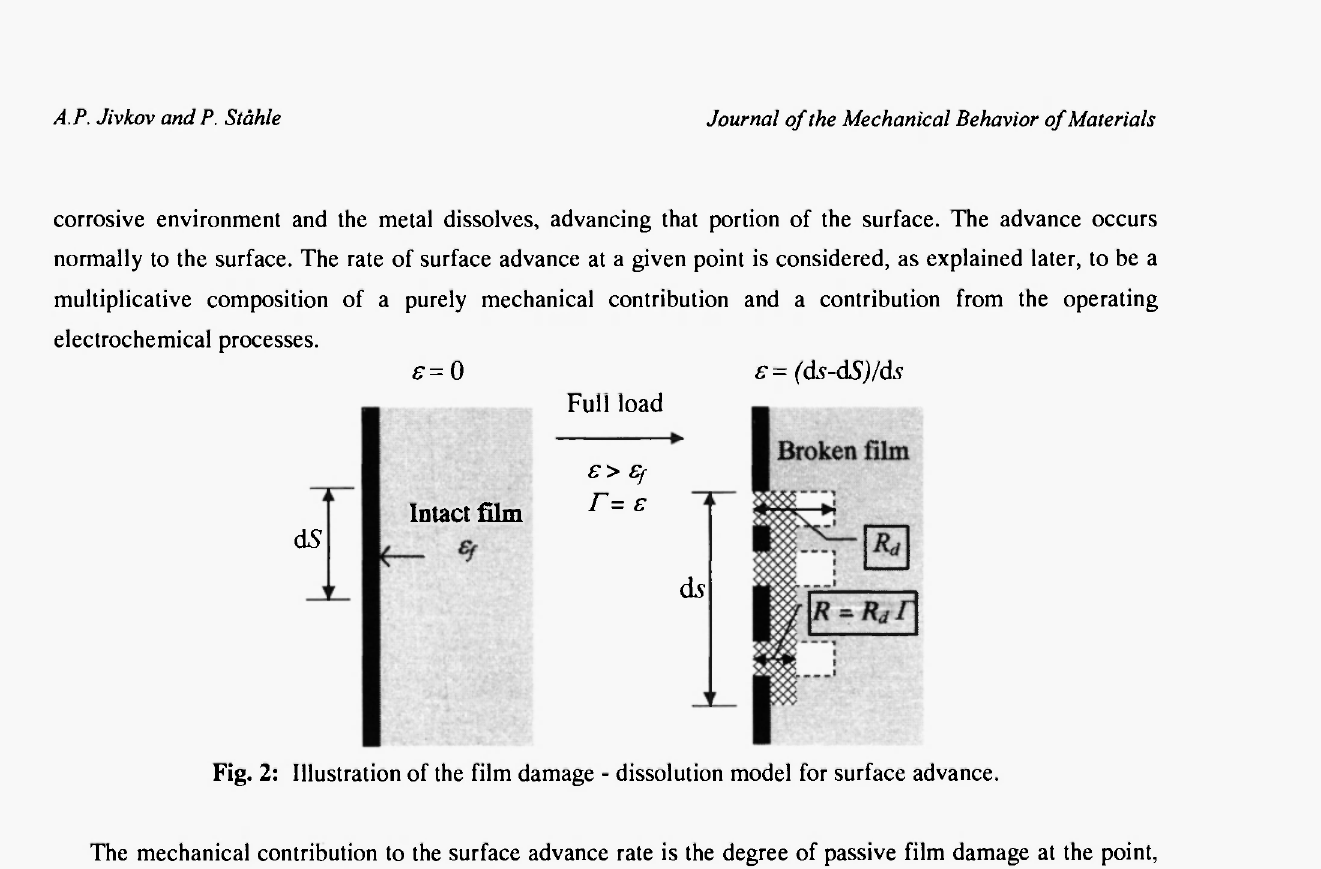
Fig. 2: Illustration of the film damage - dissolution model for surface